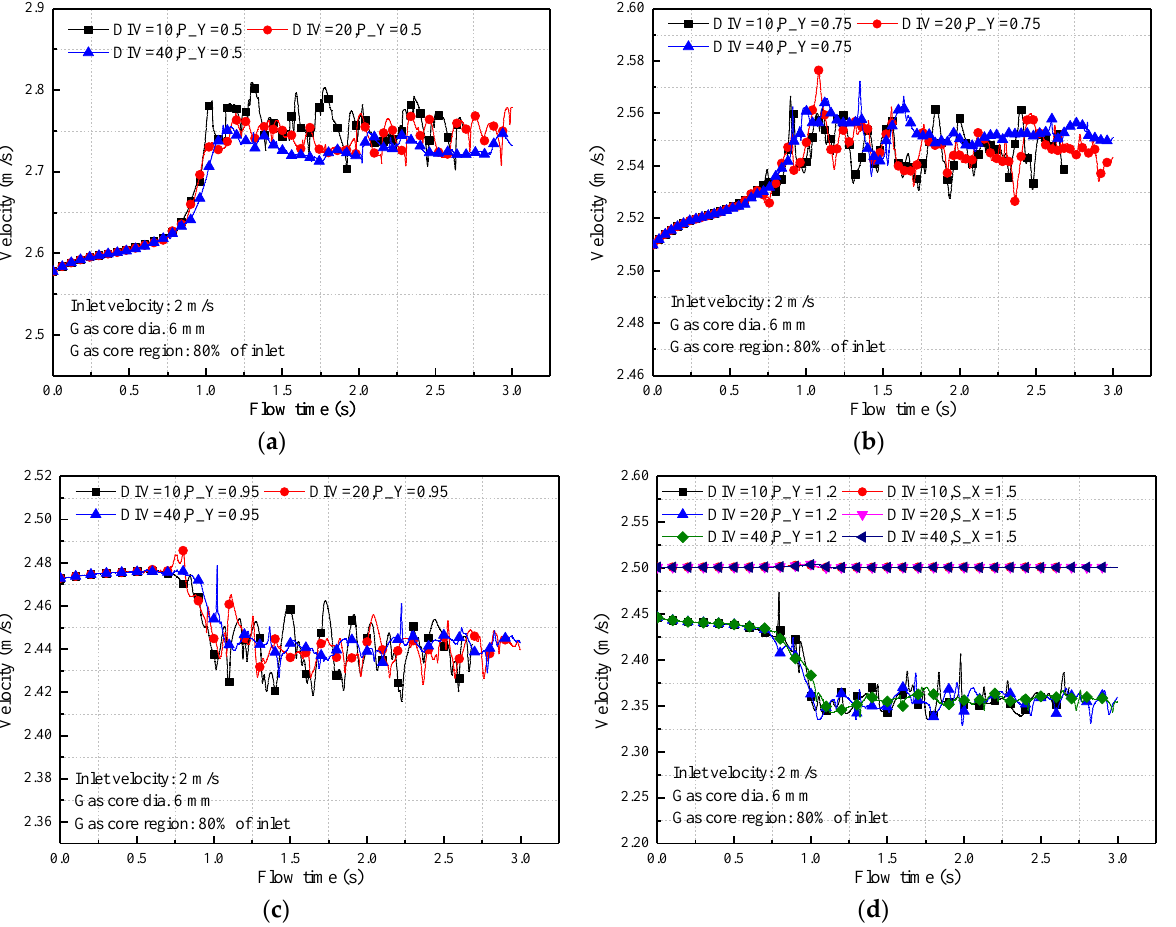
Figure 4. Magnitude of velocity fluctuation with different gas charging length: d 1 = 3, d 2 = 6 and d 3 = 12 mm, resulting bubble diameter of 2.76, 3.91 and 5.53 mm, respectively.